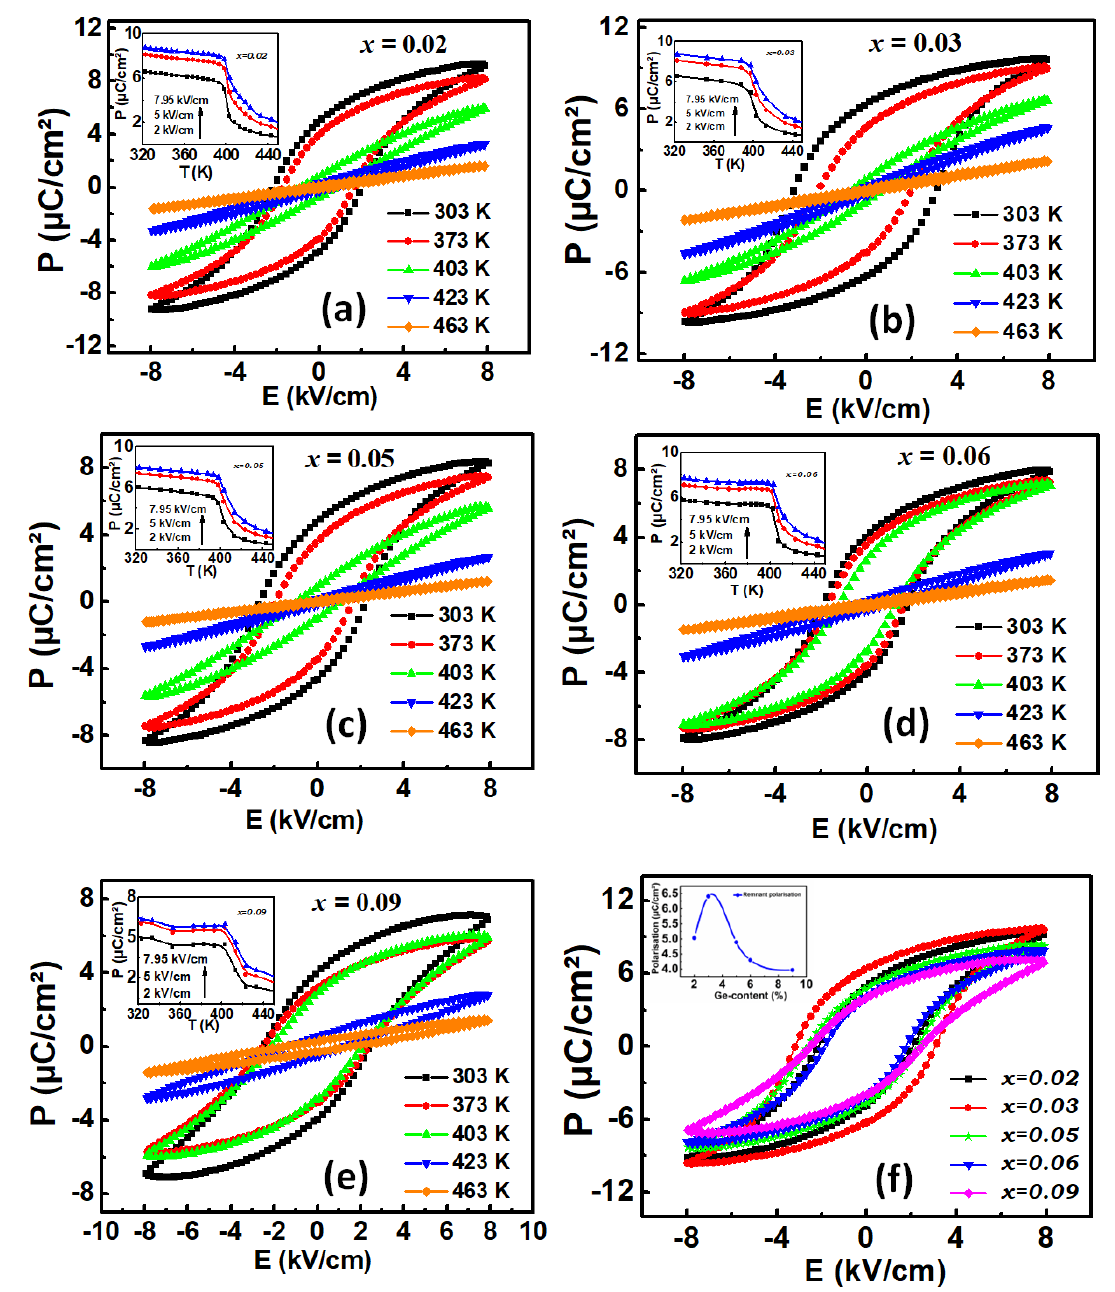
Figure 7. ( a – e ) P-E hysteresis loops of BTGx ceramics (x = 0.02, 0.03, 0.05, 0.06, 0.09) as a function of temperature and extracted maximum polarization (insets) variation versus temperature at three applied fields. ( f ) Comparative hysteresis loops at T = 303 K and remnant polarization (inset) versus Ge-content.